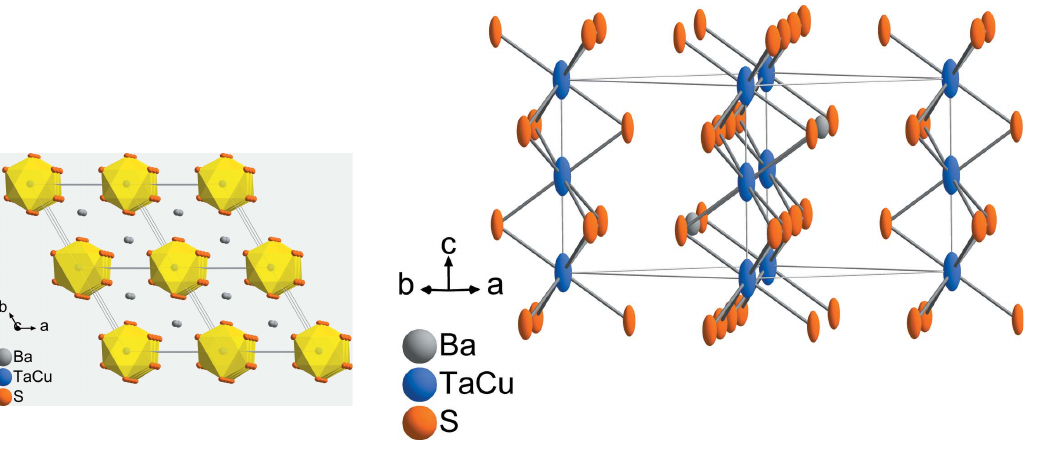
Figure 1 Face-sharing of M S 6 ( M = Cu, Ta) octahedra in the structure of BaCu 1/3 - Ta 2/3 S 3 . Displacement ellipsoids are drawn at the 50% probability